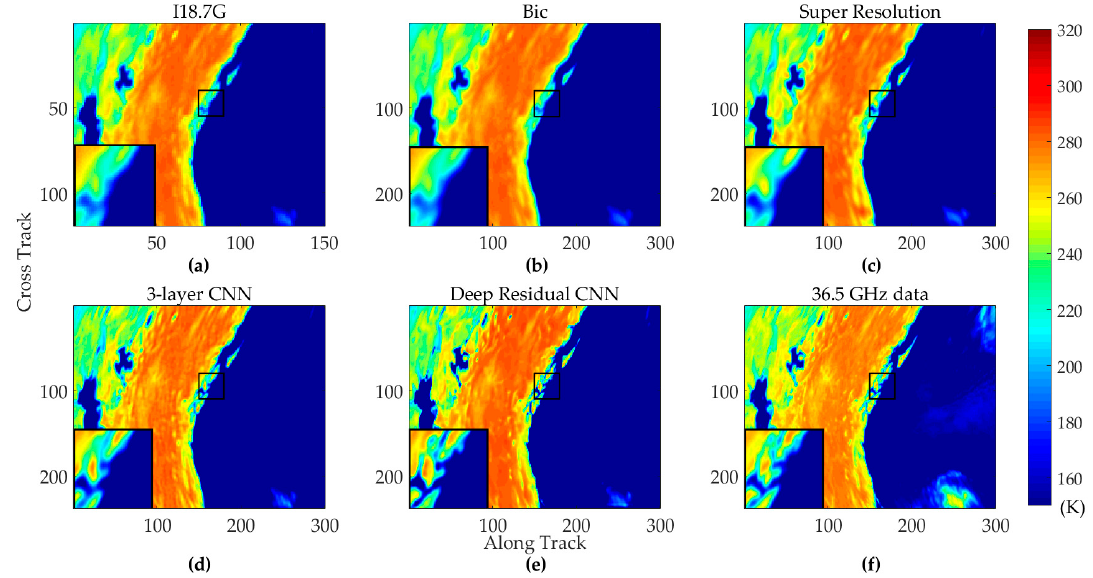
Figure 12. Tested results for the 18.7 GHz data. ( a ) The sub-sampled 18.7 GHz data I 18.7 G ; ( b ) The bicubic interpolation result; ( c ) The super resolution result; ( d ) The 3-layer CNN result; ( e ) The deep residual CNN result; ( f ) The 36.5 GHz data.